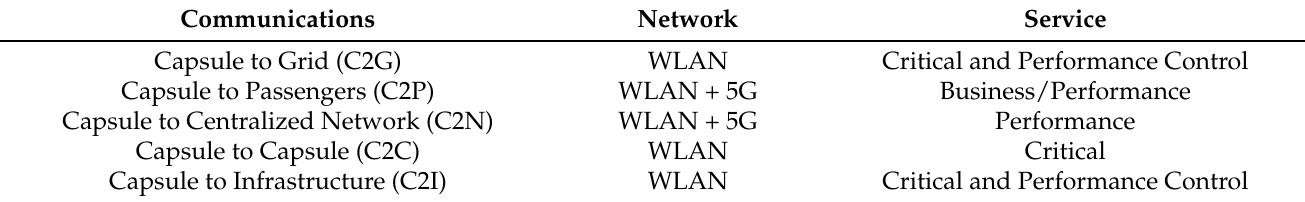
WLAN Critical and Performance